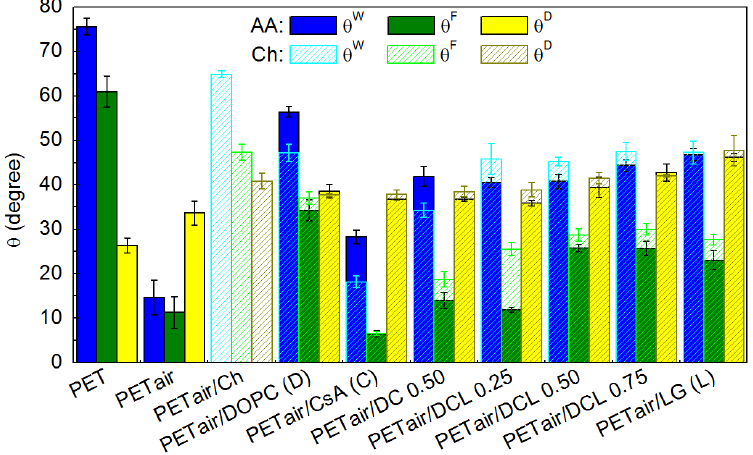
Figure 11. Contact angle values measured for the unmodified and modified by the LB films deposited from the air/AA and air/Ch interfaces, PET surfaces.